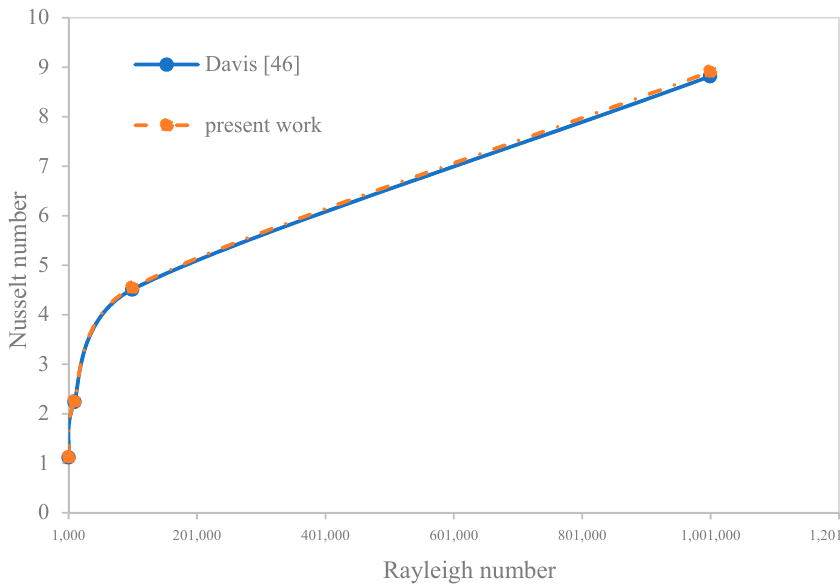
Figure 4. The comparison of the results of the present work with reference.